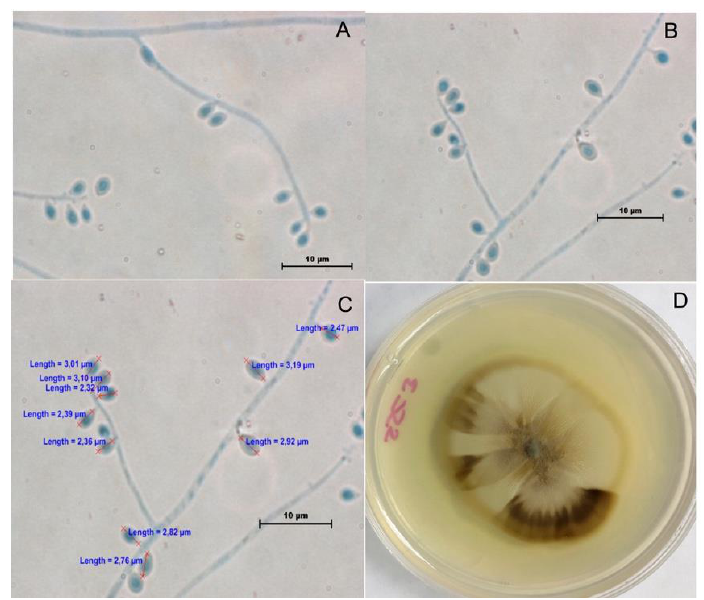
Figure 2. S . globosa morphological characteristics. ( A ) Hyphae, conidiophore, and sessile conidia (200×); ( B ) Sessile conidia (200×); ( C ) Morphometric analysis (200×); ( D ) Colony on potato dextrose agar (PDA) at 30 °C in 21 days.